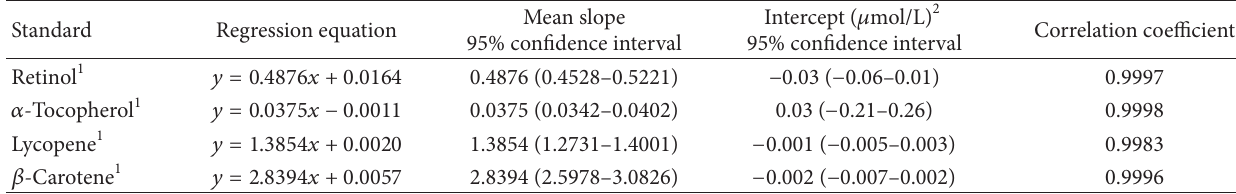
T 2: Average parameters of 10 calibration curves for the HPLC